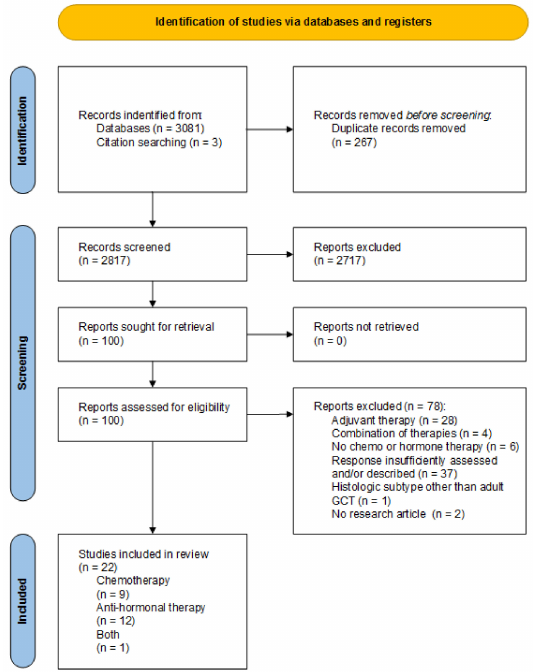
Figure 1. PRISMA Flow diagram, summarizing search